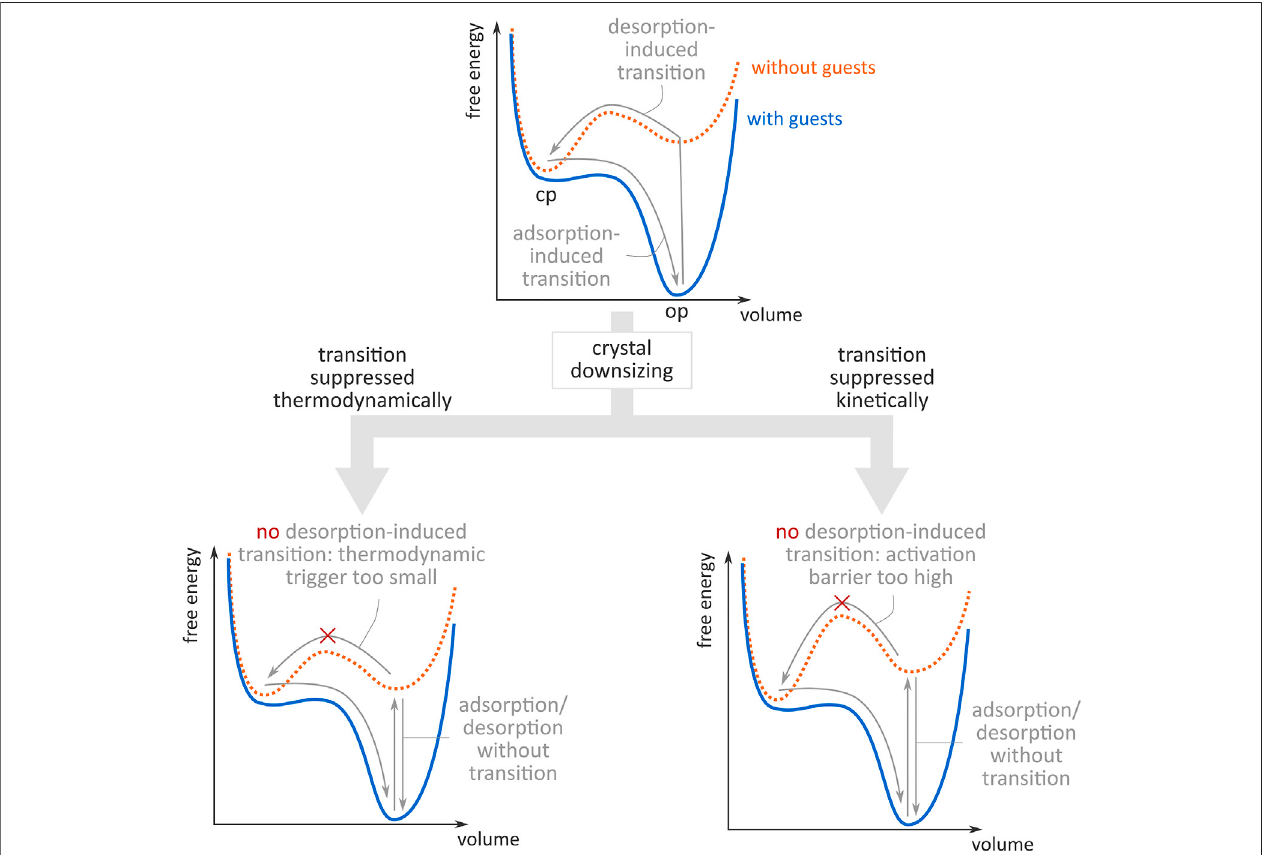
FIGURE 1 | Schematic illustration of the free energy pro fi les with (orange) and without (blue) guests in a SPC. Top: guest adsorption/desorption induces a phase transitionbetweenanopenpore(op)andaclosedpore(cp)state.Bottom:uponcrystaldownsizing,theop-to-cptransitionissuppressed,eitherthermodynamicallydue to too small afreeenergydifference between the op and the cp state (left), or kinetically due to too high an activation barrier between the op and cp state (right). Figure inspired by (Sakata et al., 2013).